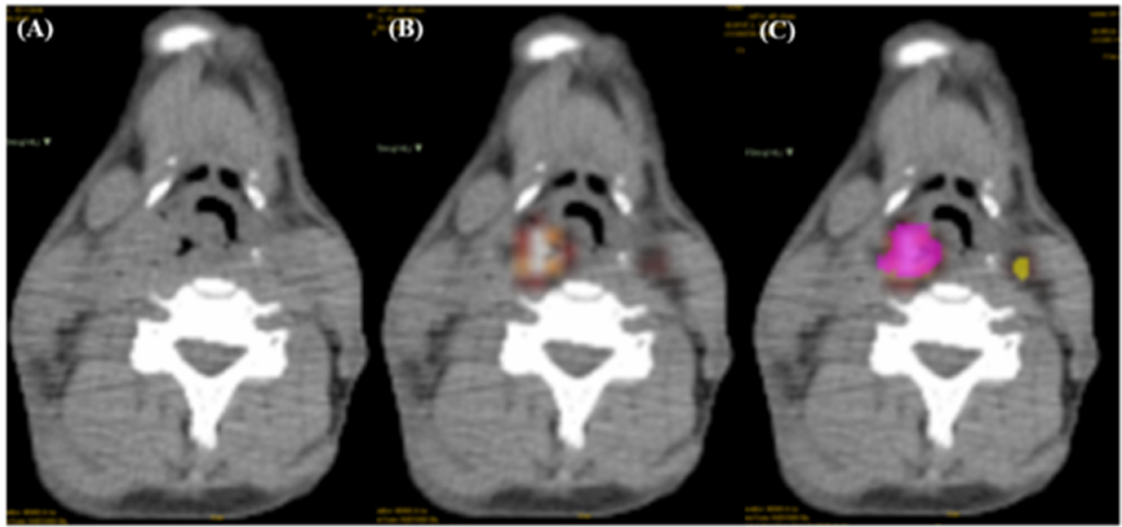
Figure 2. ( A ) CT scan ( B ) PET/CT scan ( C ) PET/CT scan with masks of primary tumor (pink) and lymph nodes